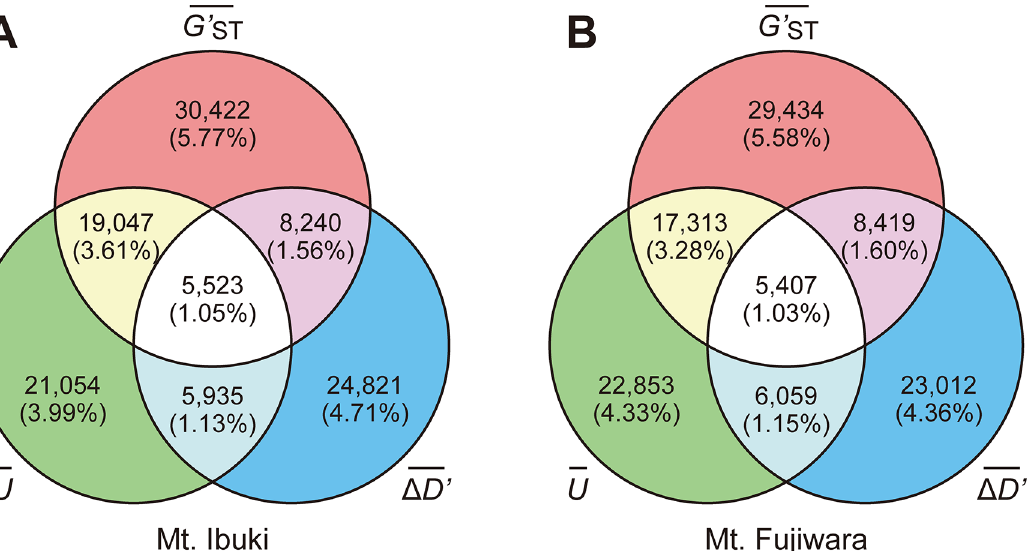
Fig 4. Overlap of screened SNPs among the three criteria. Venn diagram shows the overlaps of screened SNPs among the three criteria. The number of SNPs that fulfilled all three criteria were 5,523 (1.05% of the 527,225 SNPs) in Mt. Ibuki (A) and 5,407 (1.03% of the 527,225 SNPs) in Mt. Fujiwara